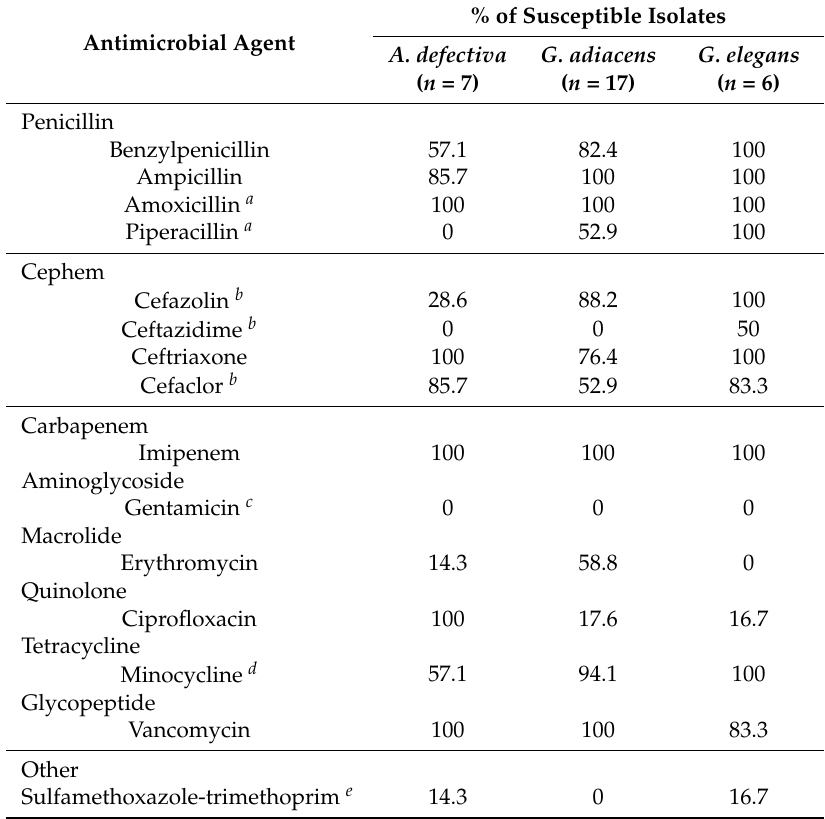
Table 3. Percentage of susceptible isolates of Abiotrophia and Granulicatella against antimicrobial agents. % of Susceptible Isolates Antimicrobial Agent A. defectiva G. adiacens G. elegans ( n = 7) ( n = 6) Penicillin